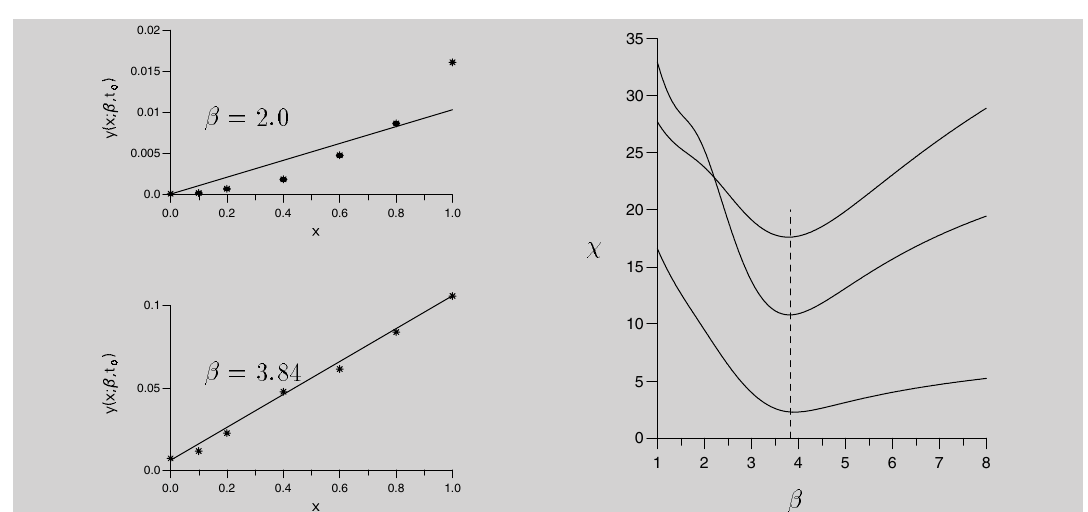
Figure 3: PMMA: β is determined to fit the data best. β =3.3 ± 0.1 describes the data better than β =2.